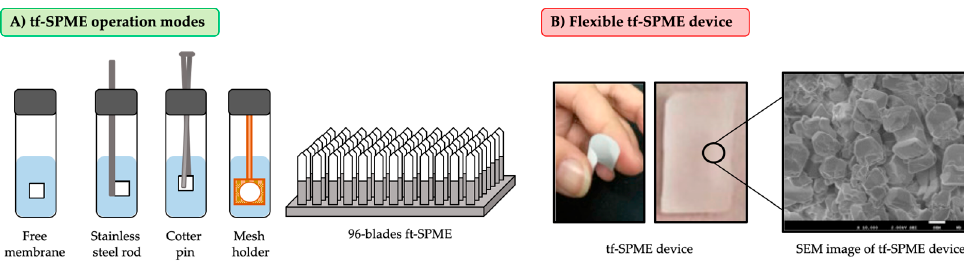
Figure 7. ( A ) Different tf-SPME sampling formats reported. ( B ) An example of MOFs incorporated in a flexible tf-SPME device. Adapted from [50], with permission from Elsevier, 2018.